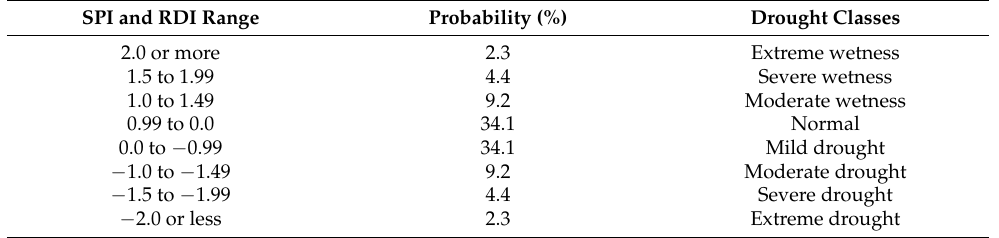
Table 2. Classification of drought and corresponding probability according to SPI and